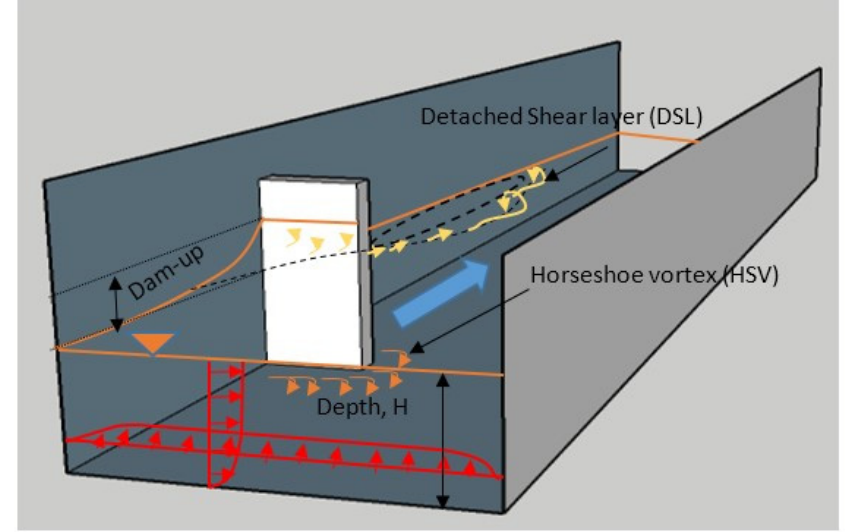
Figure 2. Conceptual description of the flow distribution around a spur dike.